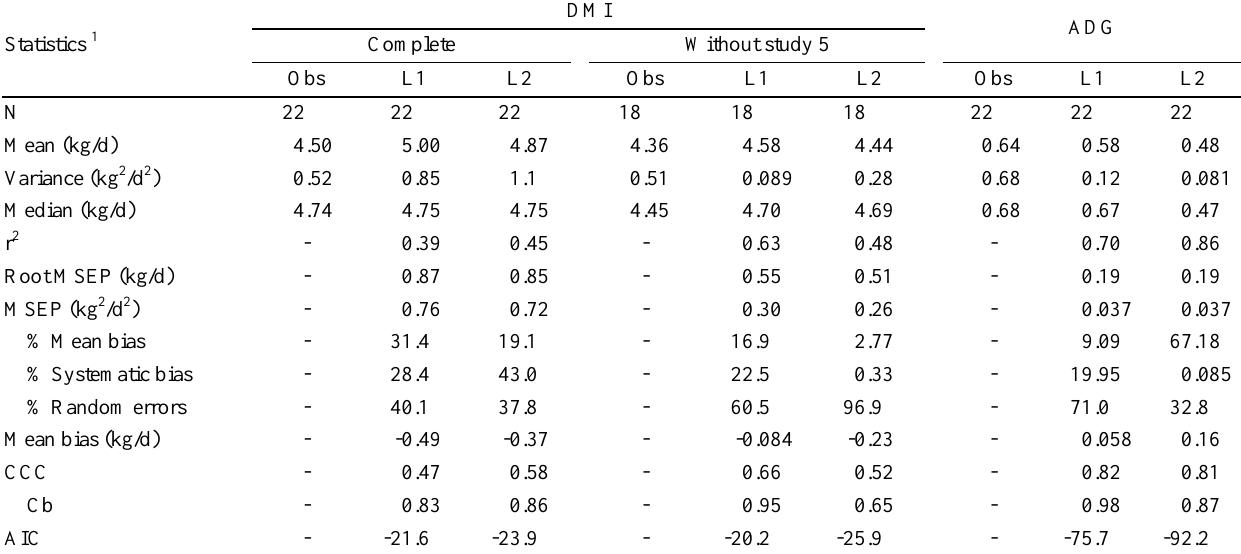
Table 4. Descriptive and adequacy statistics of observed (Obs) versus first-limiting model-predicted average daily gain (ADG, kg/d) and observed versus model-predicted dry matter intake (DMI, kg/d) using level 1 (L1) or level 2 (L2) solutions of the large